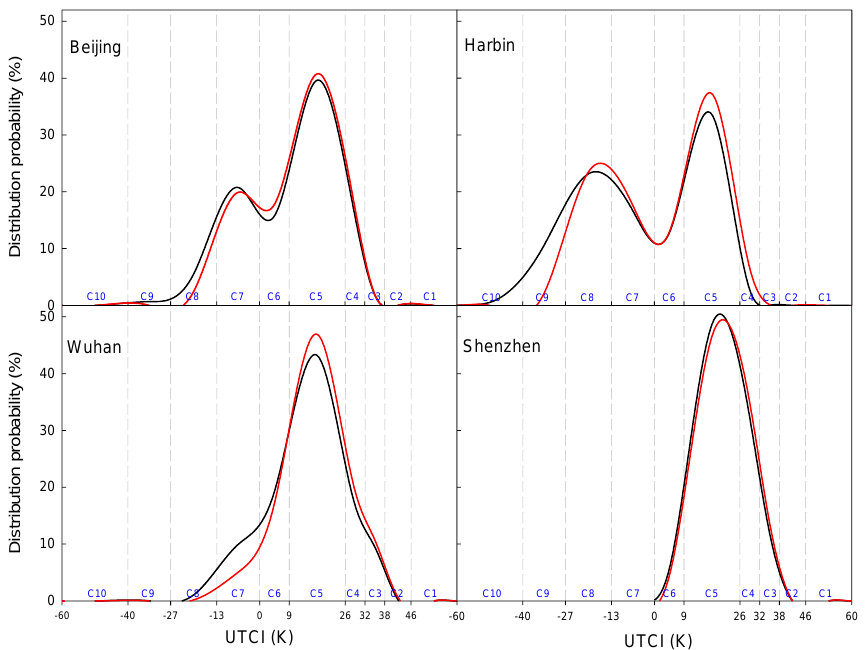
Figure 7. Distribution probability of the days within each category in the period of 1961–1990 (black lines) and 1991–2020 (red lines).